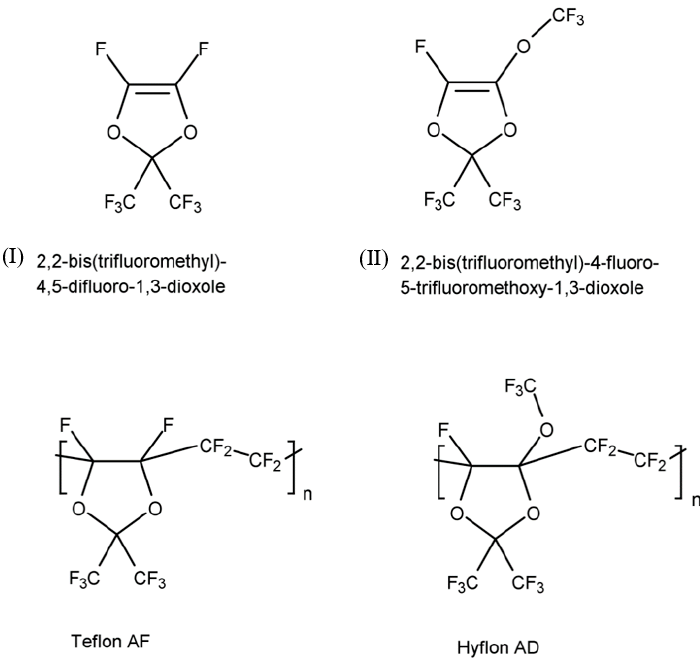
Figure 1. Chemical structures of monomers (I) and (II) and their copolymers with tetrafluoroethylene (TFE): Teflon AF and Hyflon AD.